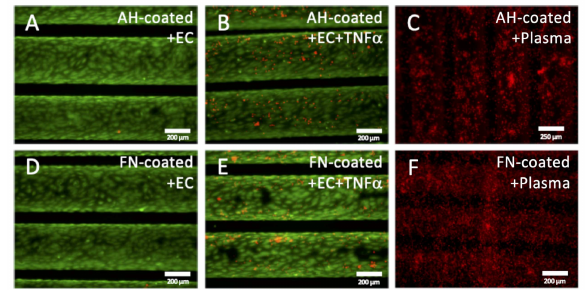
Figure 4. Leukocyte adhesion assay. Untreated ( A , D ), or rather TNF α stimulated ( B , E ) EC monolayers ( green ) on AH ( A , B ) and FN ( D , E ) coated HFM, also non-endothelialized AH ( C ) and FN coated HFM ( F ) after blood plasma immersion were incubated with HL-60 leukocytes ( red ); Scale: 200 µ